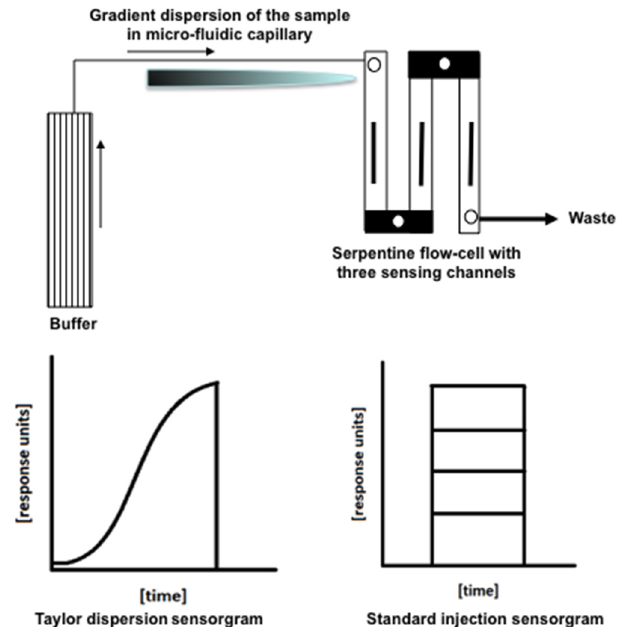
Figure 3. Schematic representation of the Taylor dispersion ( OneStep ® ) assay method. Protein-Flavonoid Interactions